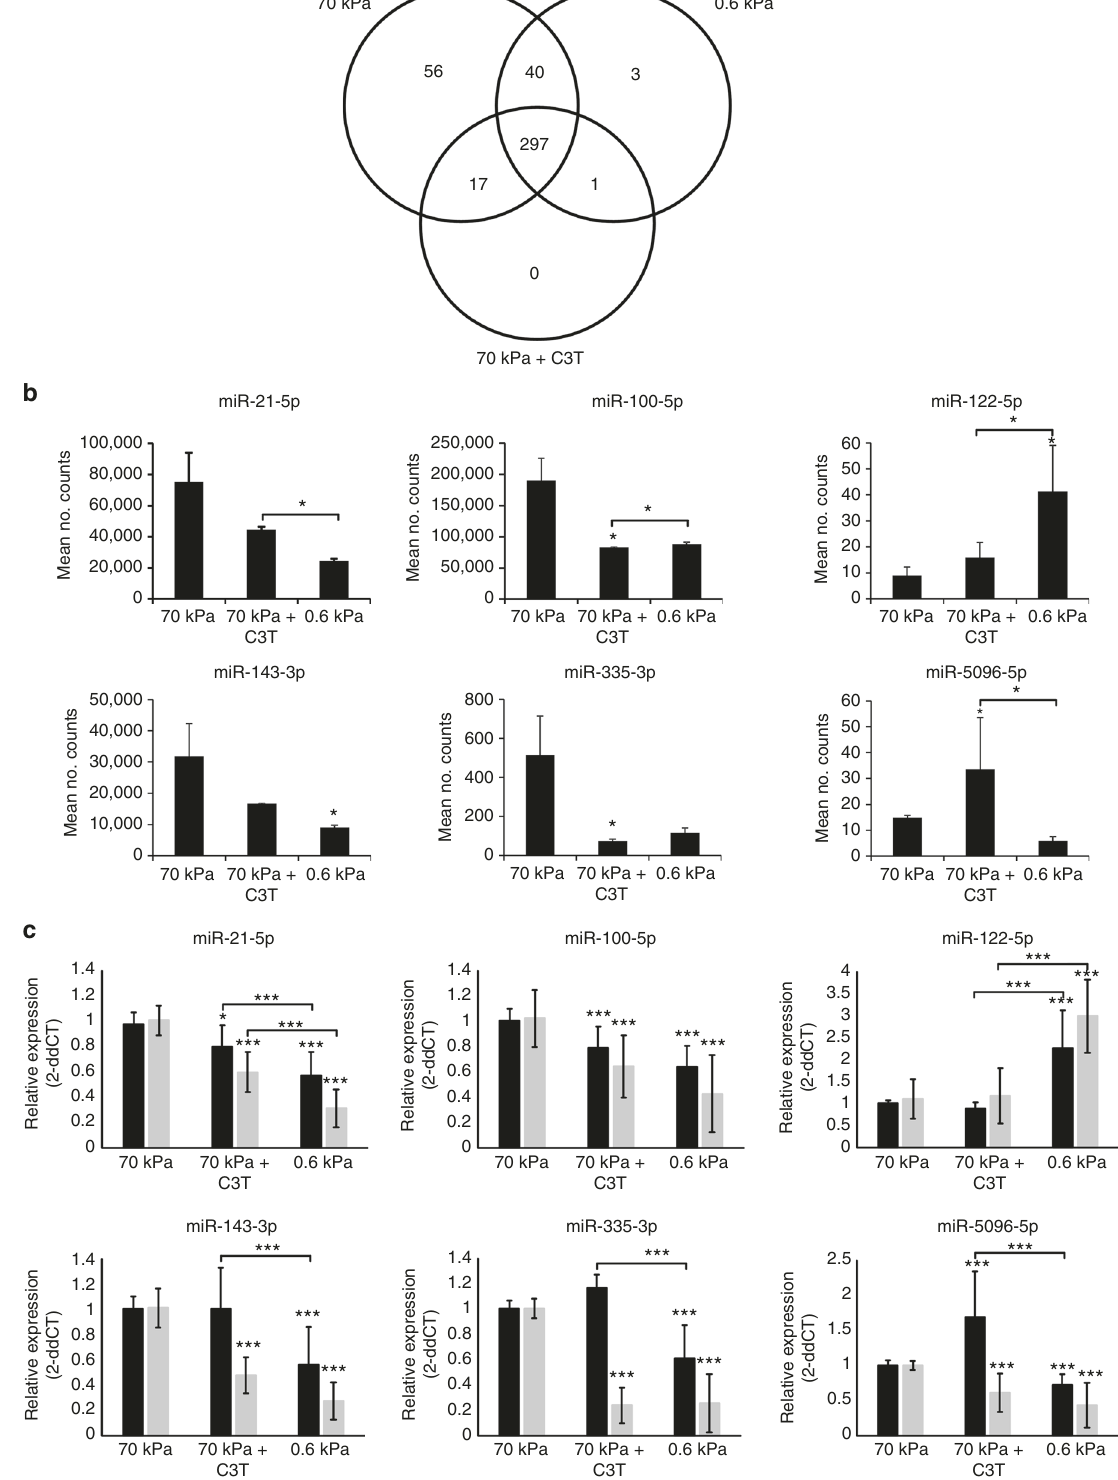
Fig. 2 Changes to miRNA expression in response to substrate stiffness and RhoA activity. a Venn diagram showing overlap of detected miRNAs between samples b Mean counts from miRNA sequencing ± SEM. c qPCR validation of miRNA expression at 24 h (black) and 7 days (grey). Data is shown relative to expression in 70 kPa samples. All data is represented as mean ± SD for four independent hMSC donors. Separate experiments were sampled for sequencing and qPCR. Samples were analysed by one-way ANOVA with Tukey post hoc testing. Statistically different samples are denoted by * p < 0.05, ** p < 0.01 and *** p <